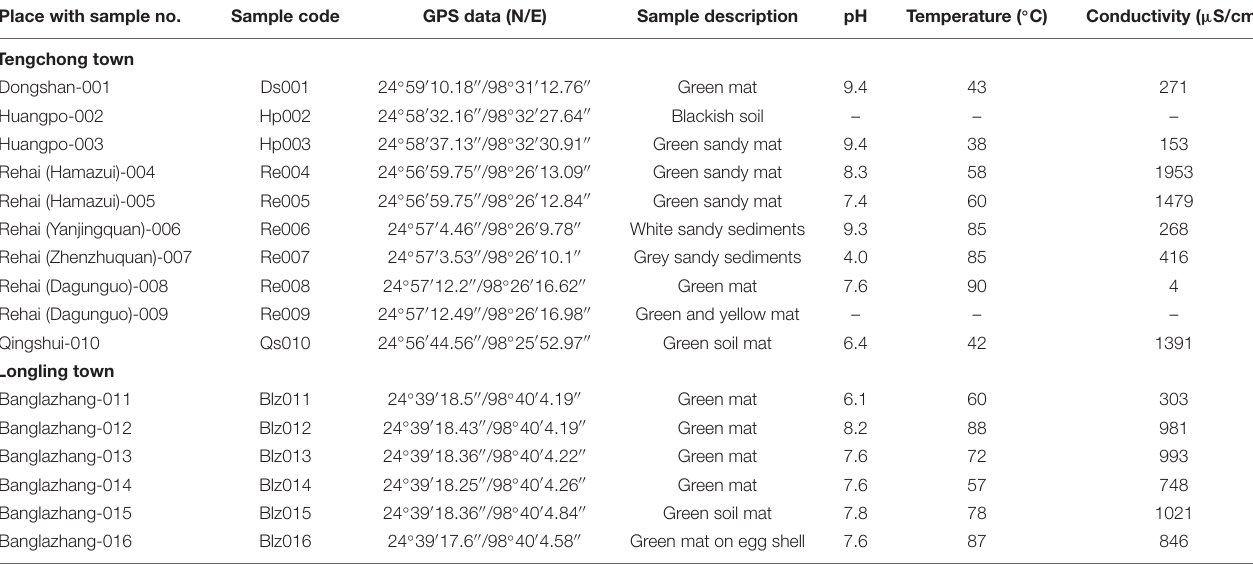
TABLE 1 | Description of the sampling sites, hot spring samples, and environmental parameters (Yunnan Province). Place with sample